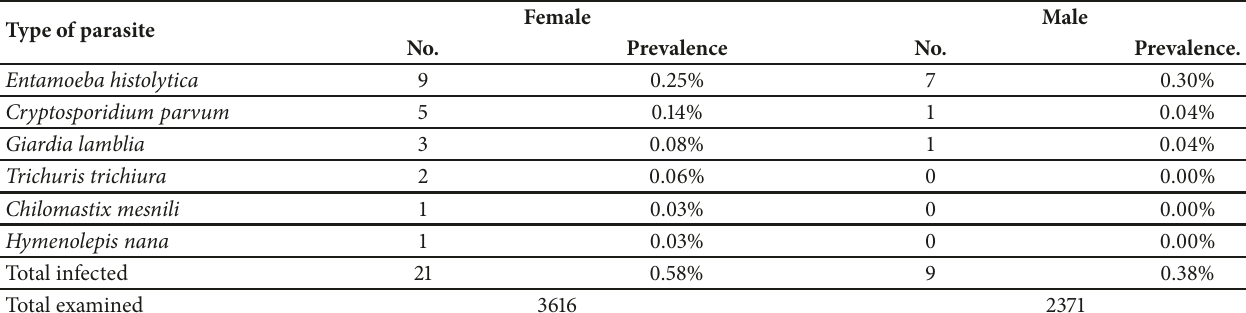
Table 3: Prevalence of intestinal parasitic infection in both males and females during the study (2013 – 2017). Female Male Type of parasite No. Prevalence No. Prevalence. Entamoeba histolytica 9 0.25%